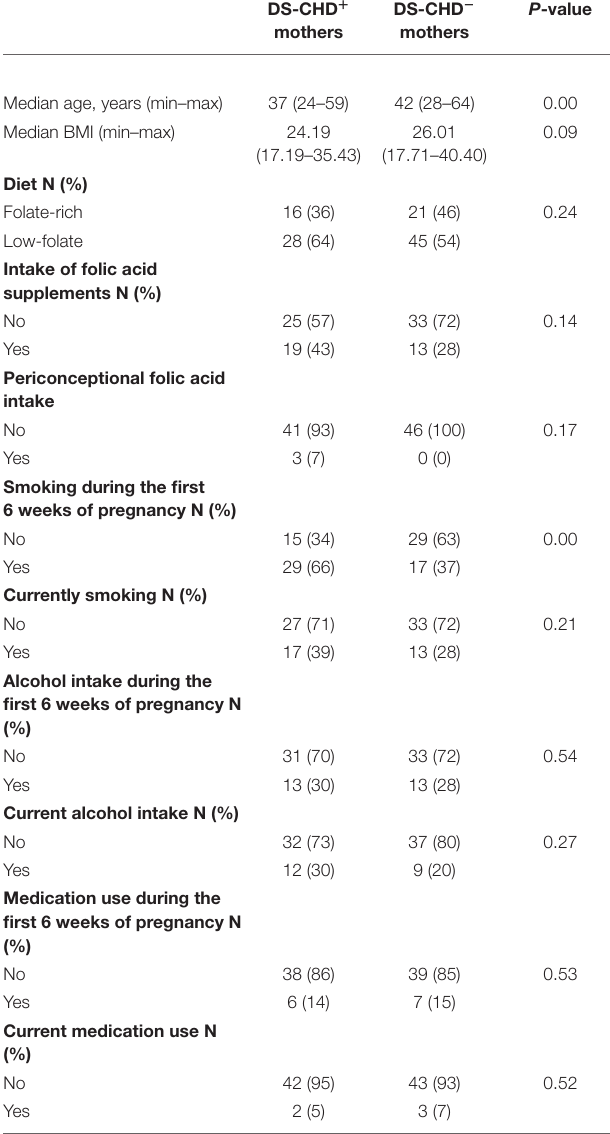
TABLE 1 | Characteristics of mothers of children with Down syndrome (DS) with or without congenital heart defects (CHDs).